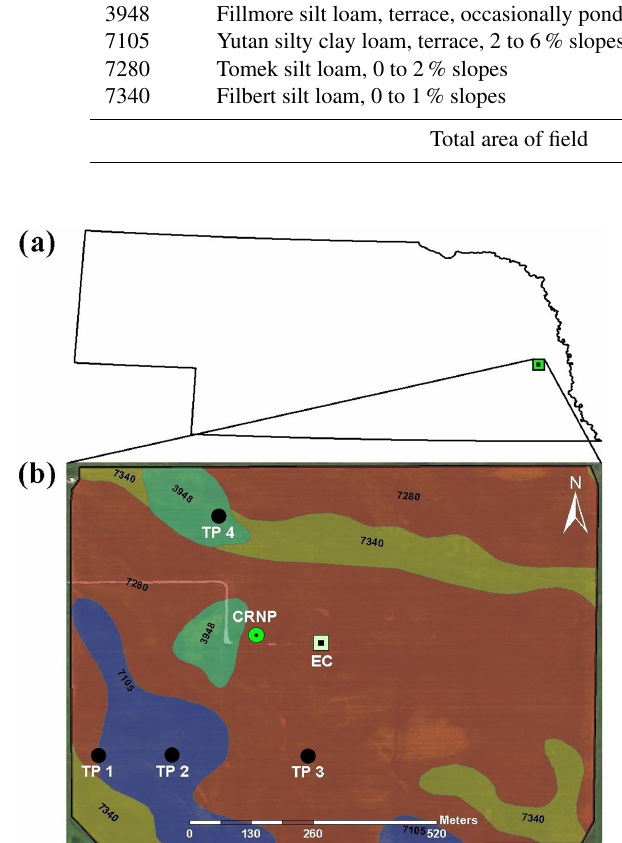
Figure 1. Study site (Mead rain-fed/US-Ne3) location in Ne- braska (a) and locations of the eddy covariance tower (EC), cosmic- ray neutron probe (CRNP), ThetaProbes (TPs), and variability of soil texture based on Web Soil Survey data at the study site, 2014 (b) . See Table 1 for soil descriptions.